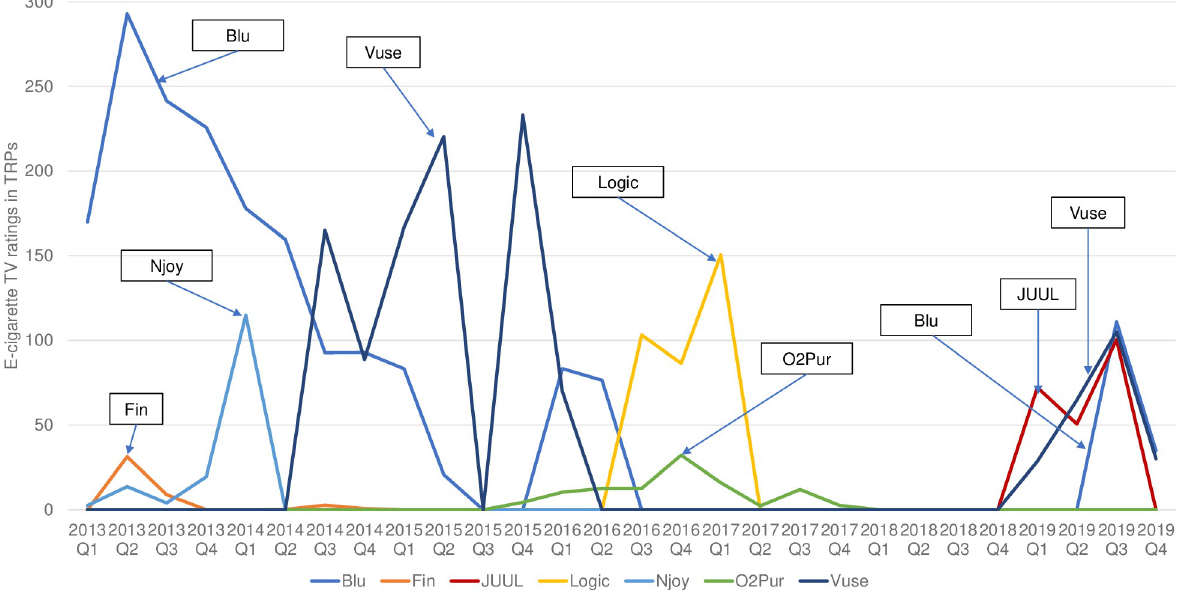
Fig 4. Youth (age 12–17) quarterly TV target rating points (TRPs) of the top 7 e-cigarette brands,